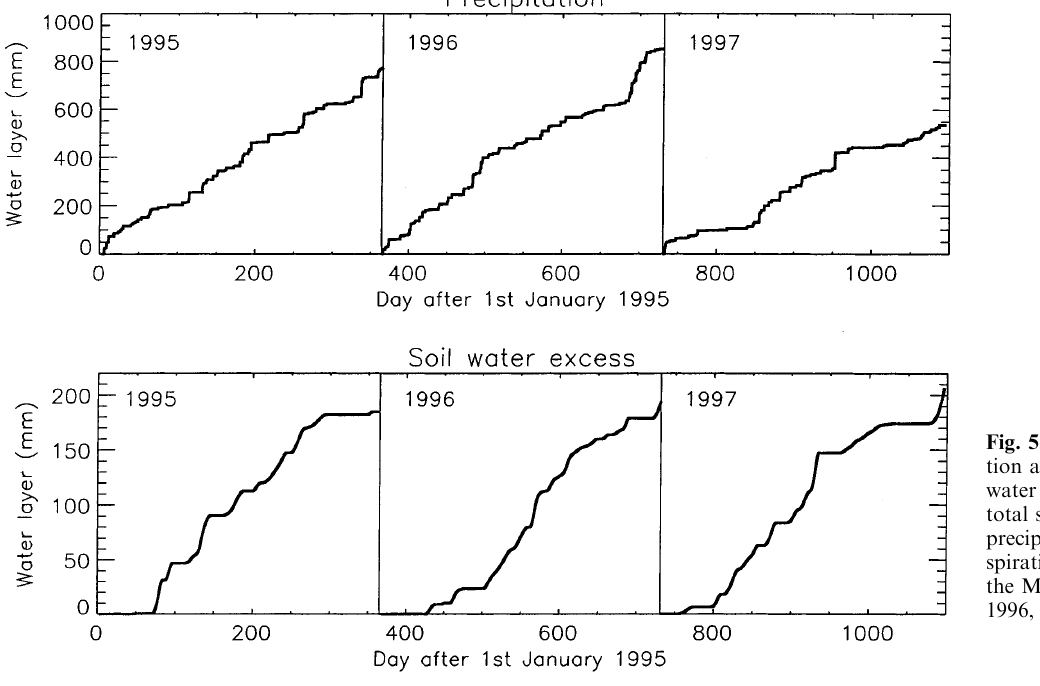
Fig. 5. Cumulative precipita- tion and positive values of the water excess derived from the total soil moisture content, precipitation and evapotran- spiration measurements over the MUREX fallow in 1995, 1996,